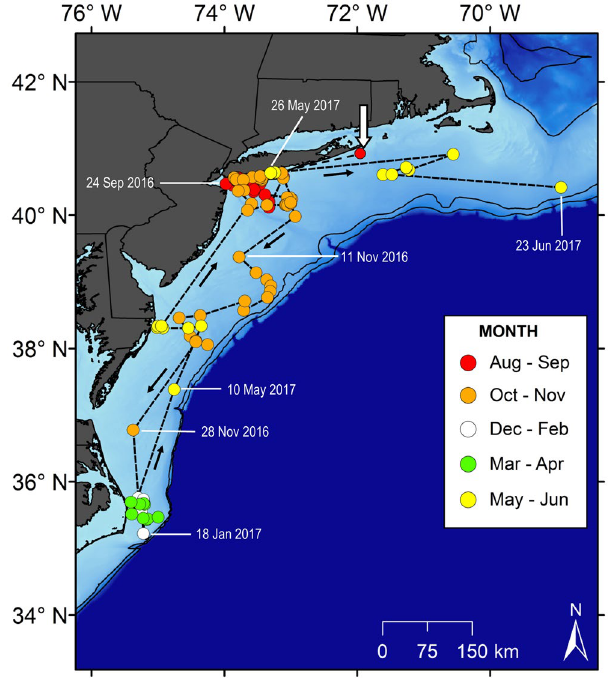
Figure 4. Complete 305-day track of a single YOY white shark (WS9), August 2016 to June 2017. The white arrow indicates the tagging location (August 23, 2016). Black arrows denote the directions of movement. Solid black lines are the 100 and 200 m bathymetric contours denoting the edge of the continental